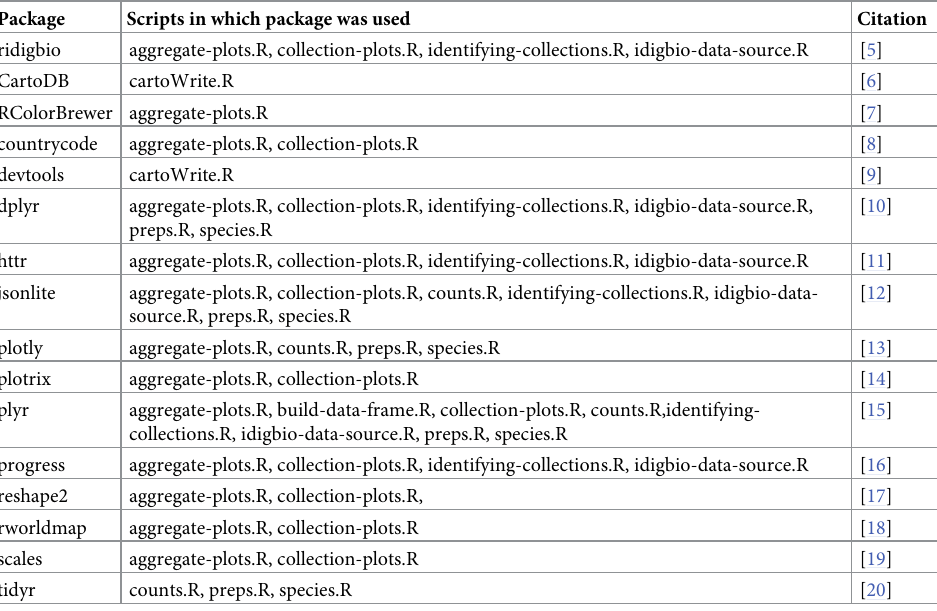
Table 1. R packages used in inventory queries, analysis and visualization. Each script generated using a package is listed. Package Scripts in which package was used Citation ridigbio aggregate-plots.R, collection-plots.R, identifying-collections.R, idigbio-data-source.R CartoDB cartoWrite.R RColorBrewer aggregate-plots.R countrycode aggregate-plots.R, collection-plots.R